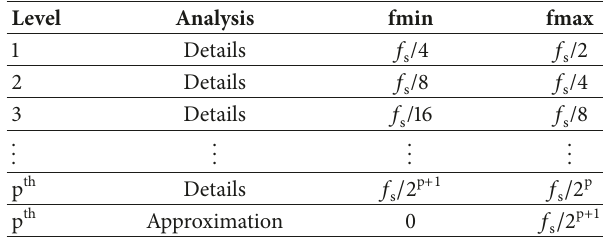
Table 1: Frequency range in levels of wavelet